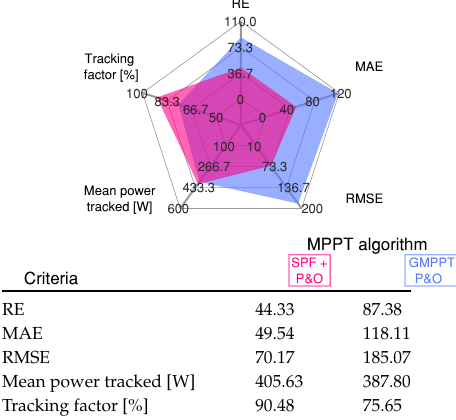
Figure 10. Comparative analysis of the MPPT methods for Scenario 3 shown in Figure 9. Therefore, the proposed GMPPT method achieves a superior performance during abrupt irradiation variations than the GMPPT P&O method. Please note that during the change from case 68 to 103, the experimental result of the SPF-P&O algorithm did not estimate an optimal reference voltage. Nonetheless, when P&O operates, GMPPT is achieved, demonstrating the robustness of the SPF-P&O